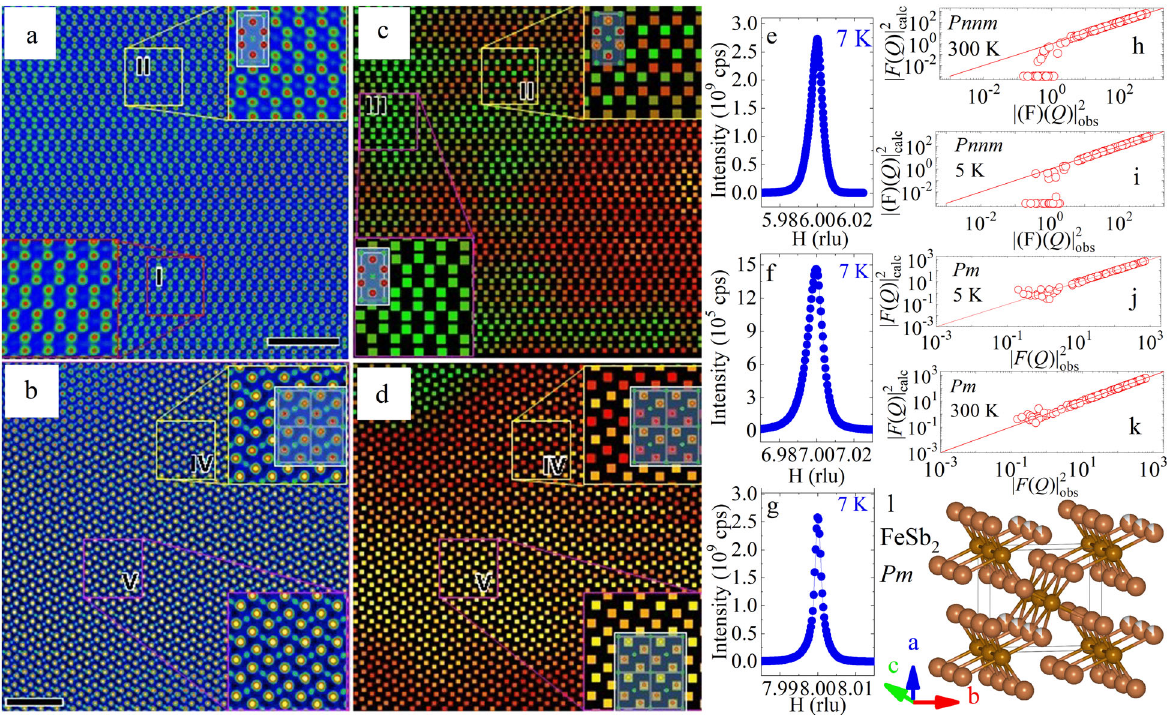
Fig. 1 Atomic defects in FeSb 2 and crystal structure distortion. a, b STEM-HAADF image of crystal S3 ( a ) viewed along Pnnm [100] direction and crystal S8 viewed along Pnnm [001] direction ( b ). The insets are the magni fi ed images from areas I and II in a (areas IV and V in b ) with the Pnnm [100] in a ( Pnnm [001] projection in b ) projection of the structure embedded. Scale bar 2 nm. The contrast is approximately proportional to Z 1.7 along the atomic column, thus the dots with strong and weak contrast correspond to Sb and Fe column, respectively. Red and green spheres represent Sb and Fe, respectively. c , d Sb peak intensity maps re fi ned from a and b , respectively. Each square represents an Sb column with intensity increasing in black – blue – green – orange – yellow – white order. The insets are magni fi ed maps from areas II to V. Note that the smooth Sb peak intensity oscillation from top to bottom in b and d could be attributed to thickness variation. e – g Synchrotron X-ray diffraction scans of crystal S8. H is the Miller index of the diffraction from ( H 00). Pnnm -forbidden peak is observed at [100] wavevector ( f ), about 3 orders of magnitude weaker than nearby Bragg peaks. Pnnm ( h , i ) and Pm ( j , k ) unit cell re fi nements obtained in single-crystal neutron diffraction experiment on low thermopower crystal, con fi rming structural distortion. l Pm unit cell of FeSb 2 induced by atomic defects. Central octahedral atom Fe (dark) is surrounded by Sb (light). The defects are preferably on Sb11 atomic sites (white arrow-marked light